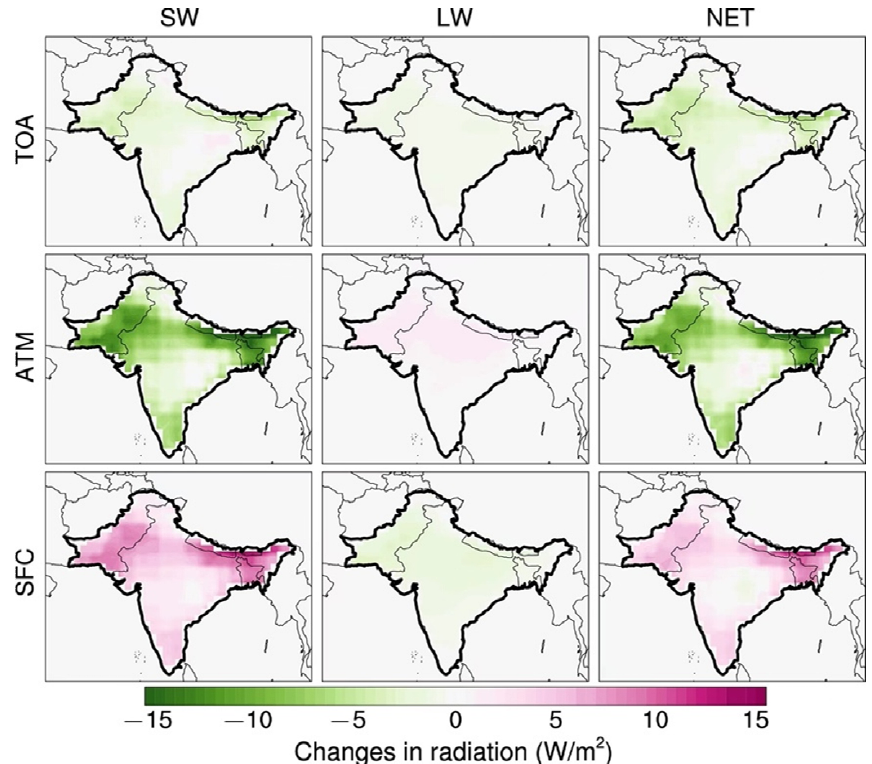
14 of 18 Table 2. Changes (lockdown minus climatology) of the shortwave (SW), longwave (LW), and NET (SW + LW) radiation flux at the top of atmosphere, in the atmosphere, at the surface over North, Central, and South Indian subcontinent (Figure 1) during the lockdown period in 2020. Data are retrieved from the Clouds and the Earth’s Radiant Energy System (CERES). The lockdown period is defined as 1 January–23 March in 2020, and the climatology is the same date range from 2005 to 2019. Radiation